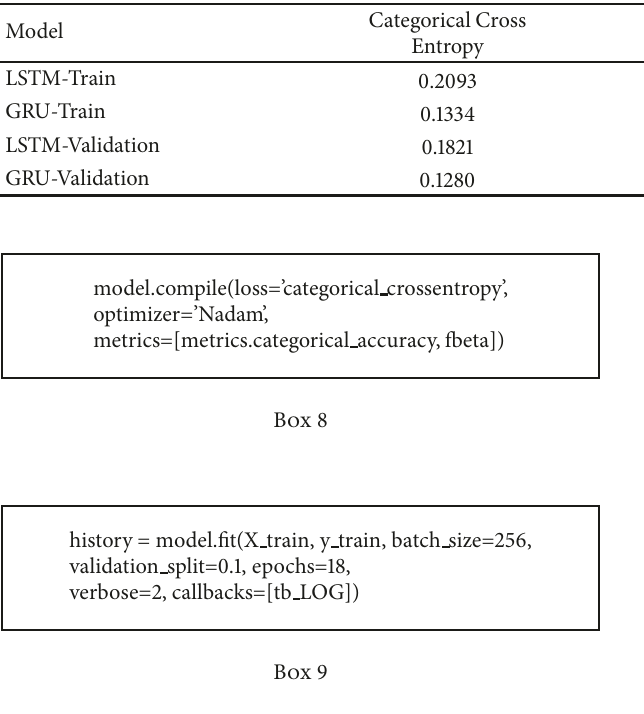
Table 2: Results of evaluation metrics for LSTM and